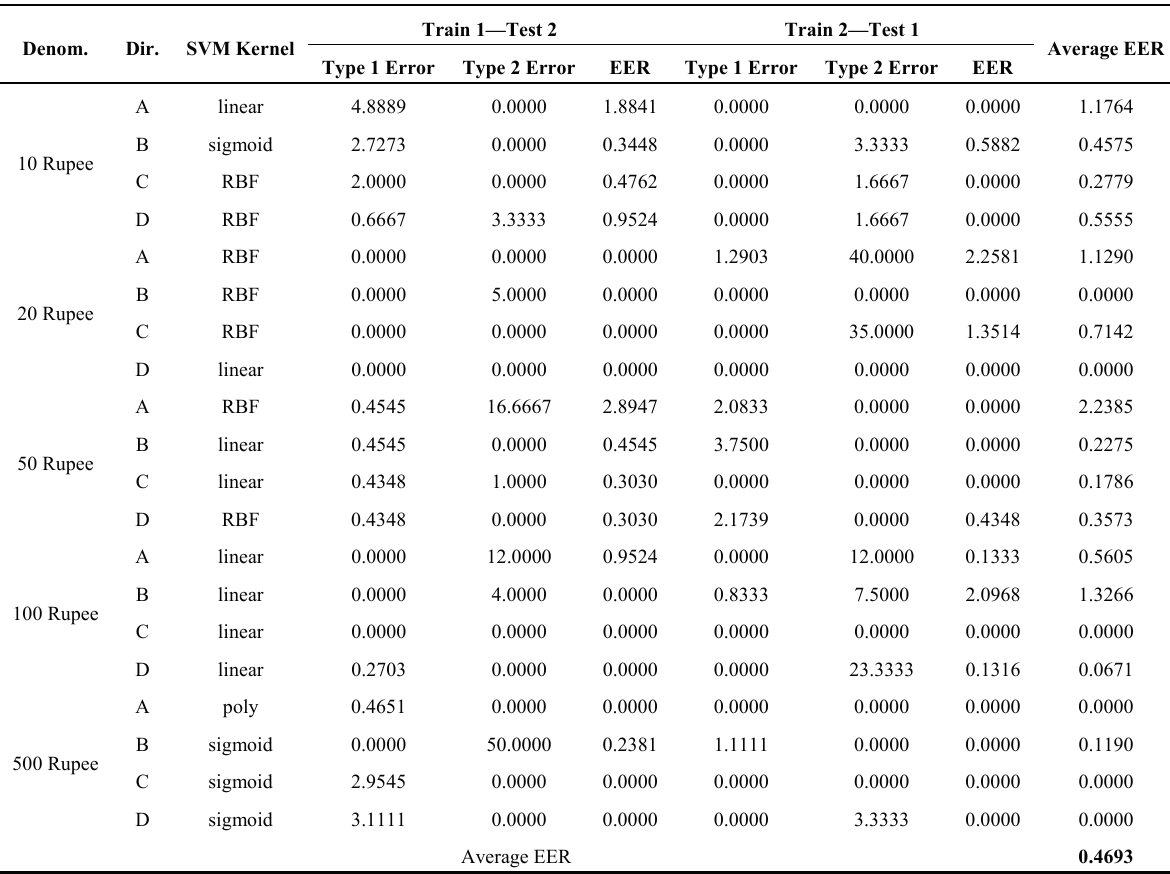
Table 4. Experimental results with testing data by Haar DWT and SVM classification. ( Denom . and Dir . are denominations and directions, respectively. Poly indicates a polynomial kernel.) (unit: